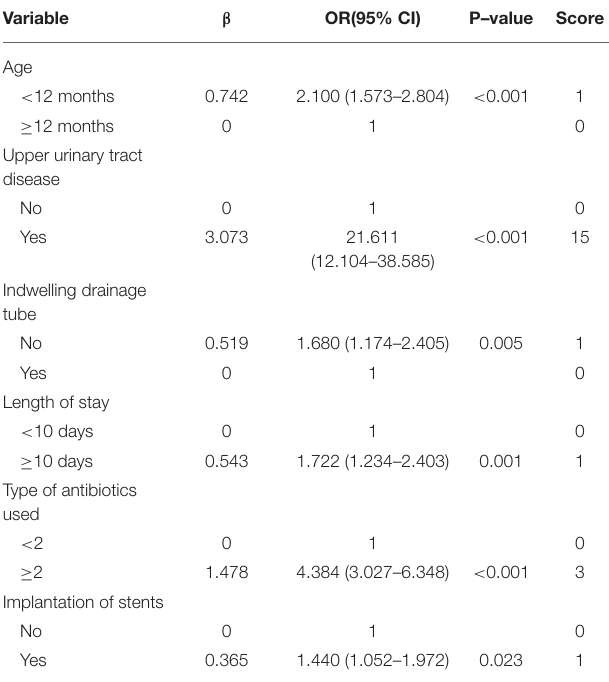
TABLE 2 | Scores of particular risk factors in the predictive model for